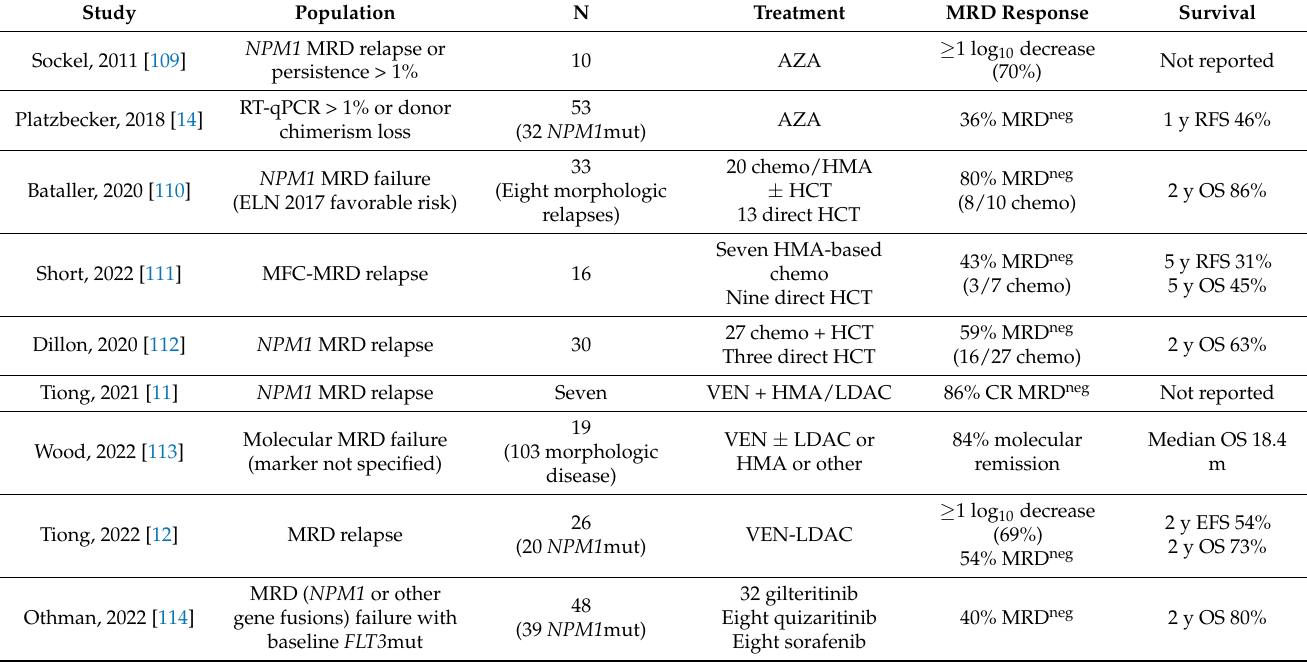
Table 4. Summary of MRD-guided therapy in